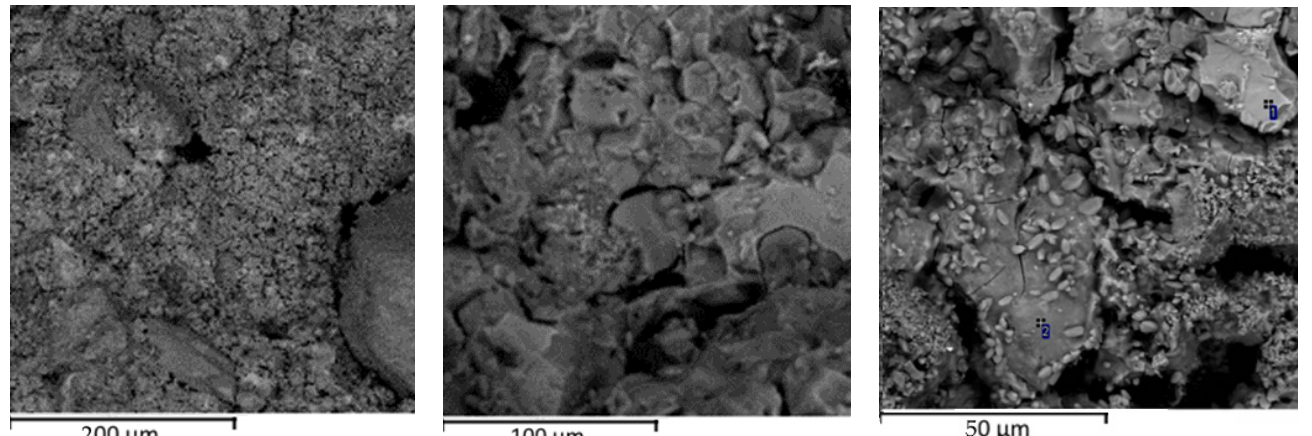
Figure 8. Microstructures of the AAMs with clinker dust. According to the results of X-ray diffraction analysis of the AAMs produced with the